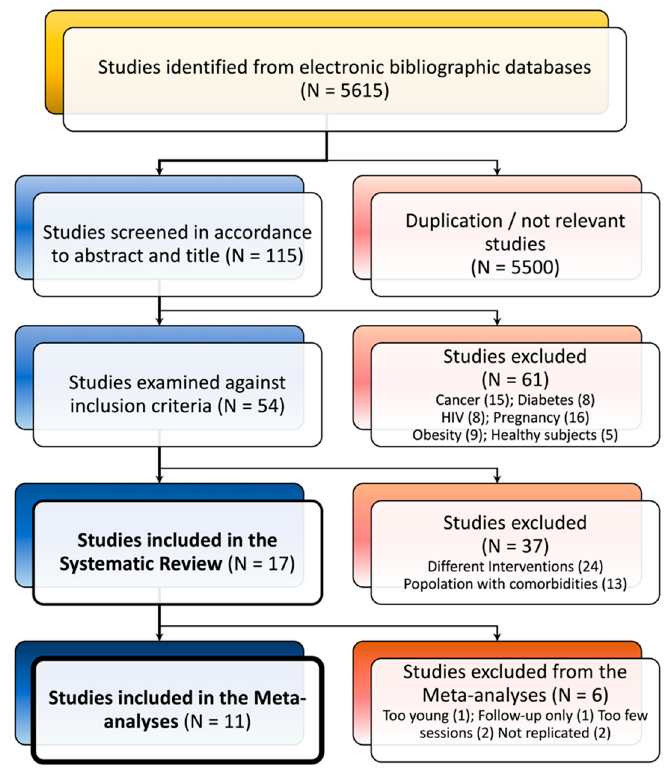
Figure 1. Flowchart of studies’ identification.